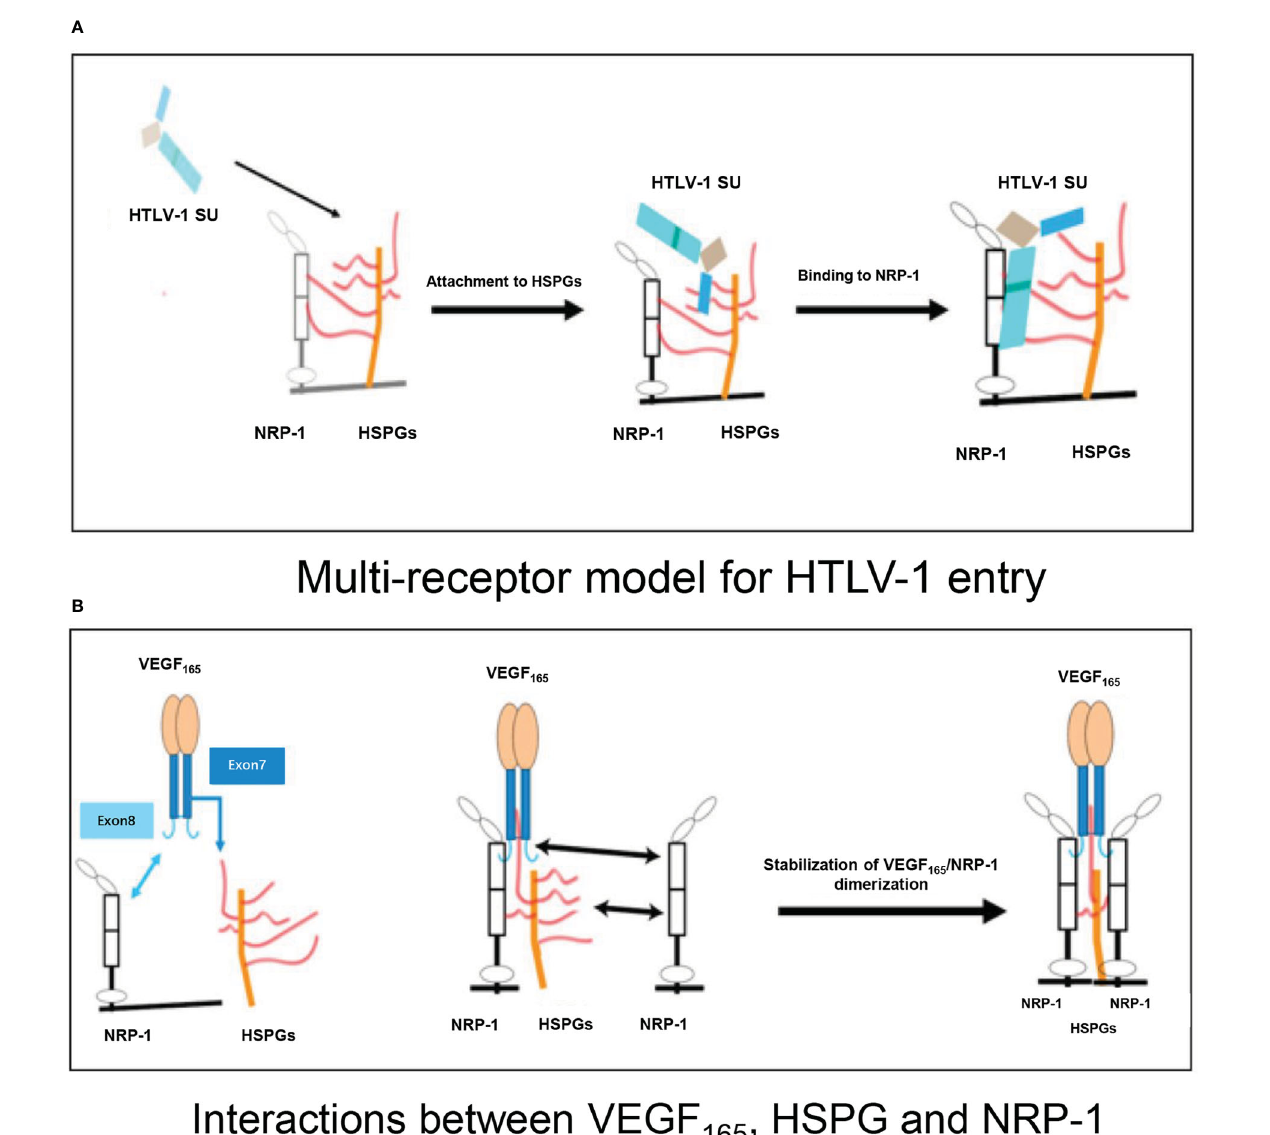
FIGURE 1 (A) Multi-receptor model of the initial phase of HTLV-1 entry into target cells. HTLV-1 SU interacts with HSPG, resulting in the initial attachment and concentration of HTLV-1 particles on the cell surface. The interaction of HSPG with SU and NRP-1, and the direct binding of SU to NRP-1 then result in the recruitment of NRP-1, enabling stable binding of SU to the HSPG/NRP-1 complex. (B) Schematic representation of interactions between VEGF 165 , HSPG, and NRP-1. The sequence encoded by exon 7 of the VEGF 165 gene binds to HSPG, and the sequence encoded by exon 8 binds directly to NRP-1. The NRP-1 dimer is then formed, resulting in enhanced stability. HTLV-1: human T-cell lymphotropic virus type 1; SU: surface subunit; HSPG: heparan sulfate proteoglycan; NRP-1: